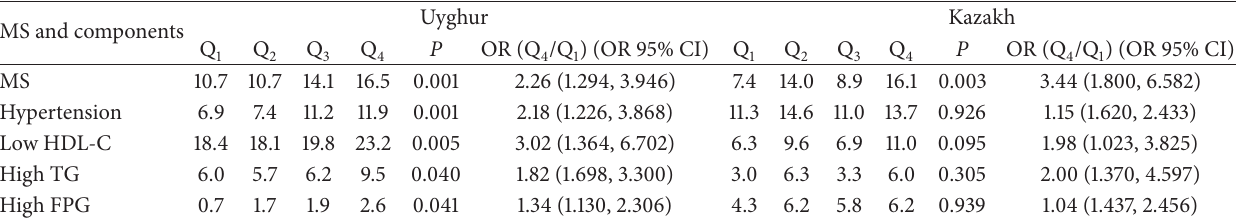
Table 5: Detection rates of MS and components in each FFA level quartile.